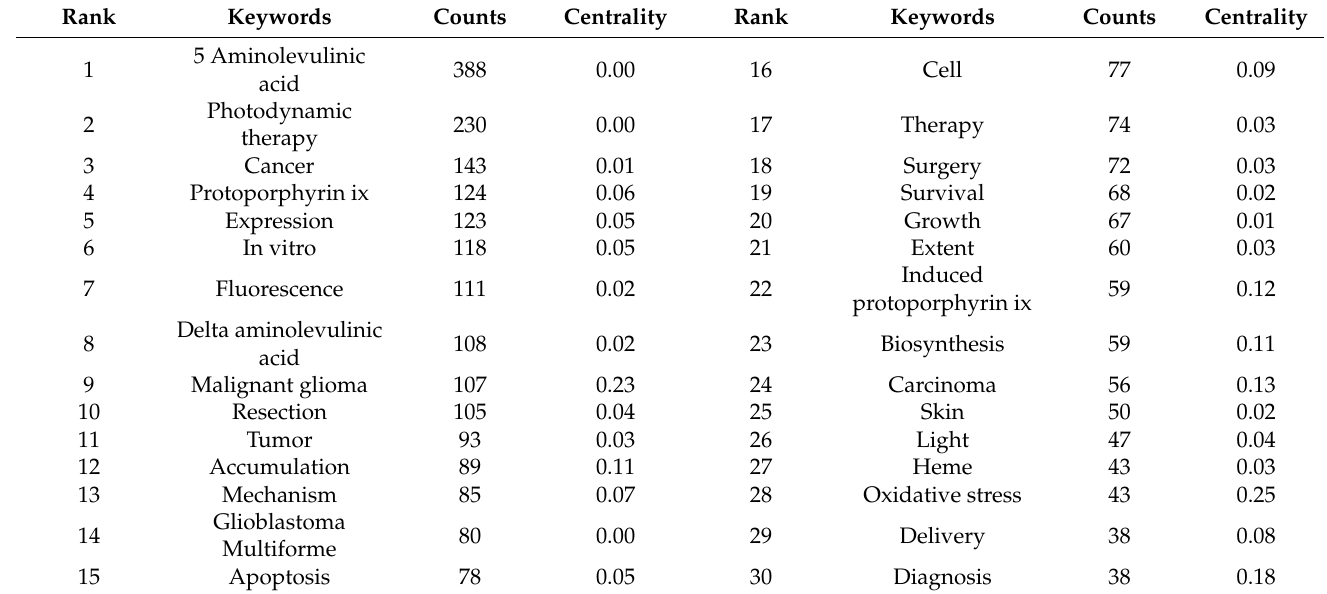
Table 4. The top-30 keywords with the largest occurrence